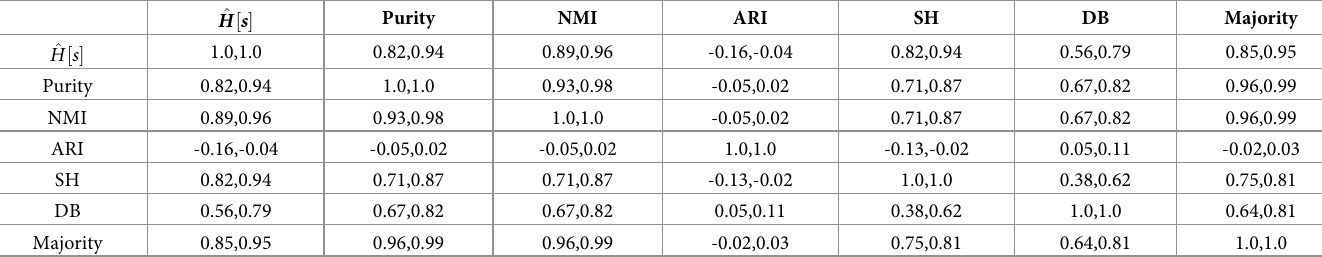
Table 5. Kendall’s τ and Spearman’s correlation result for Crime (robbery).